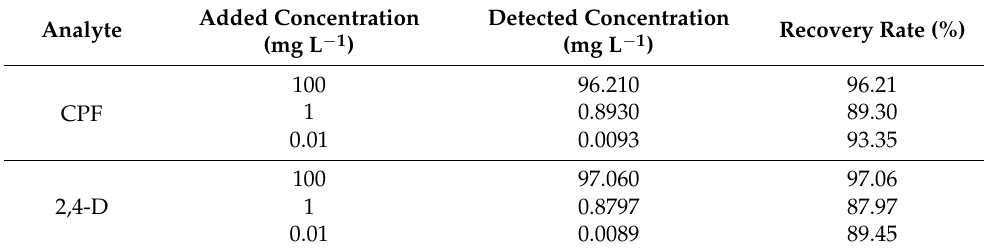
Table 4. Recovery results of CPF and 2,4-D on apple surface sample.